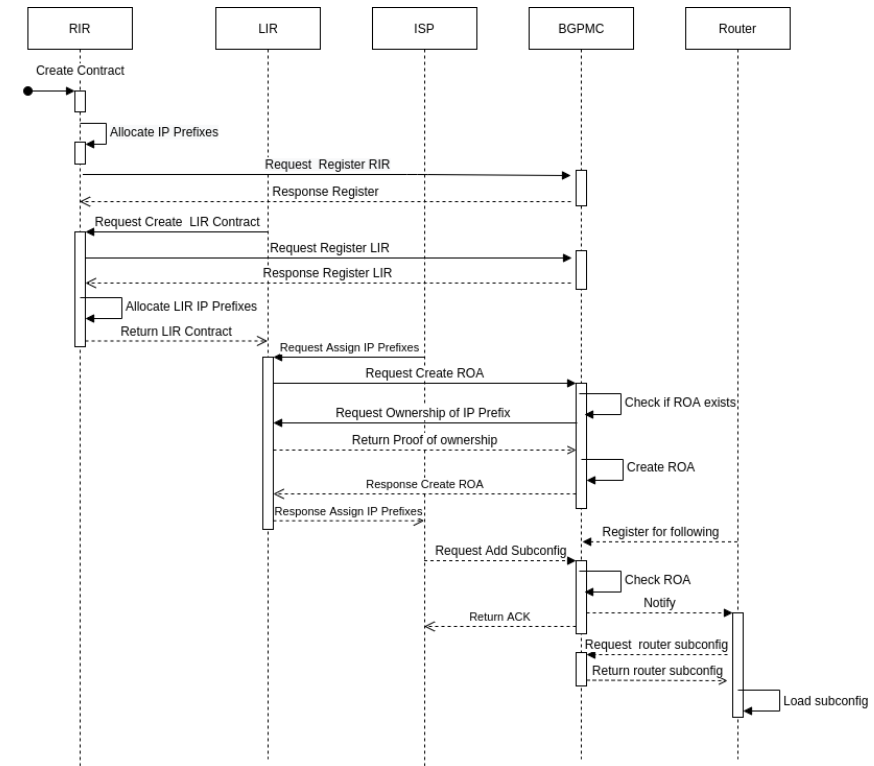
Figure 3. Management sequence